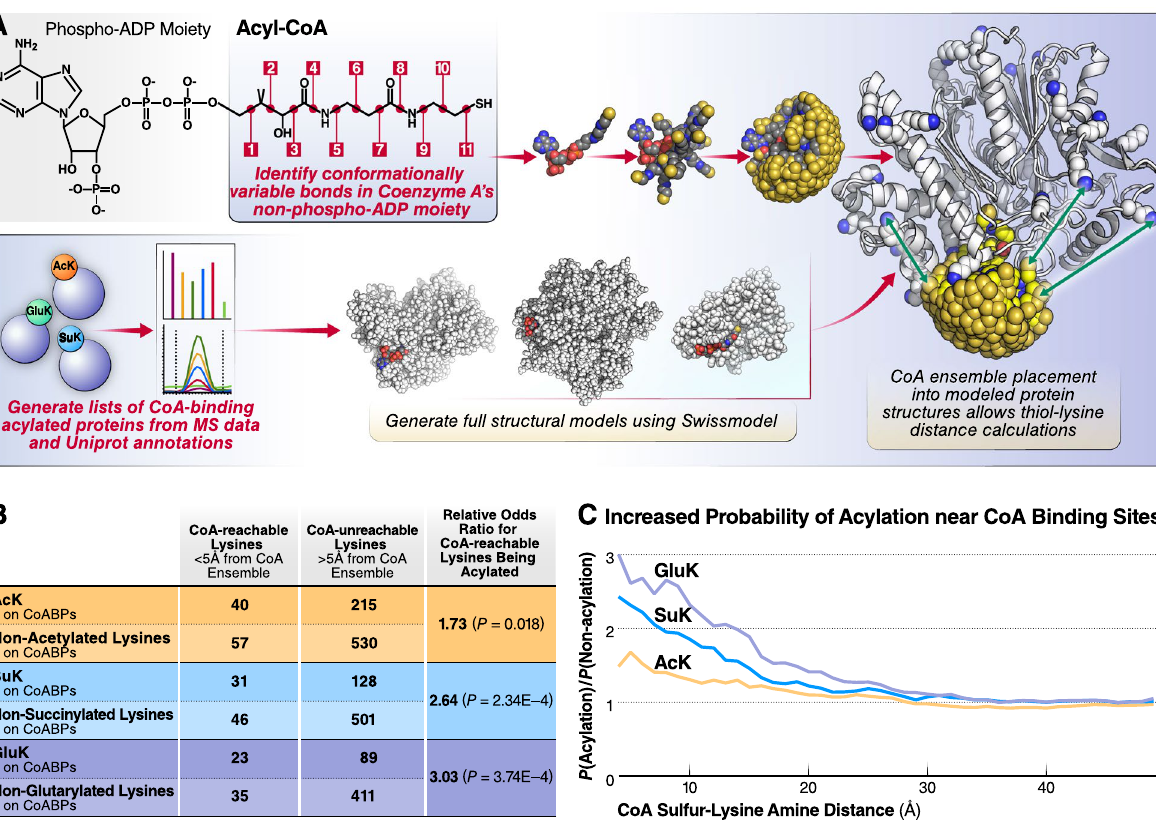
Figure 3. Structural modeling of CoA conformation reveals proximal hyperacylation near CoA-binding sites ( a ) Schematic diagram of the computational approach used to calculate the minimal distance between a lysine residue the CoA’s thiol group in a protein CoA-binding pocket. A conformational ensemble of physically plausible CoA conformation was made by combining experimentally observed bond rotational angles from CoA crystal structures after the phospho-ADP moiety. Full structural models of CoA-binding proteins from acylomic datasets were generated using Swissmodel. The CoA ensemble was docked into each protein model to generate a set of sterically accessible CoA thiol locations and used to score each modeled lysine residue’s amine-thiol distance. ( b ) Table showing the numbers of non-acylated and acylated lysine residues found on CoA-binding proteins. Relative odds ratio for CoA-reachable lysines (< 5 Å from the nearest CoA ensemble sulfur) being acylated vs. more distal lysine residues were calculated for each of acetylation, succinylation, and glutarylation. The significance of the results was calculated using Fisher’s exact test. ( c ) Relative probability of lysine acylation on CoA binding protein lysines as a function of a lysine’s distance from the CoA ensemble. Data shown for acetylation, succinylation, and